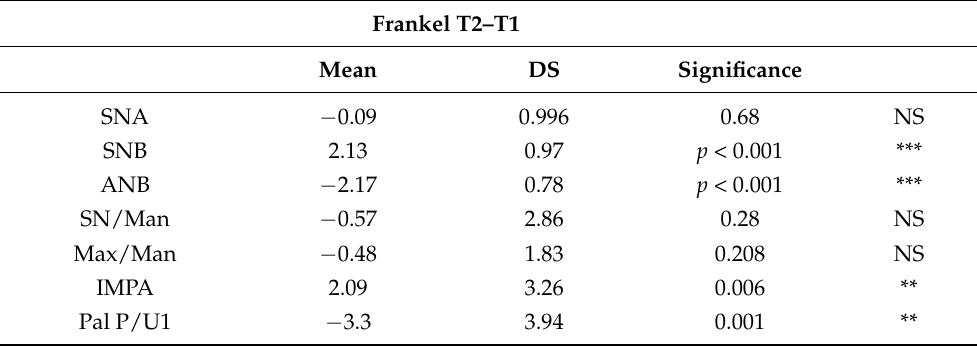
Table 3. Data collection of the differences in the variables considered between the time T1 and T2 for